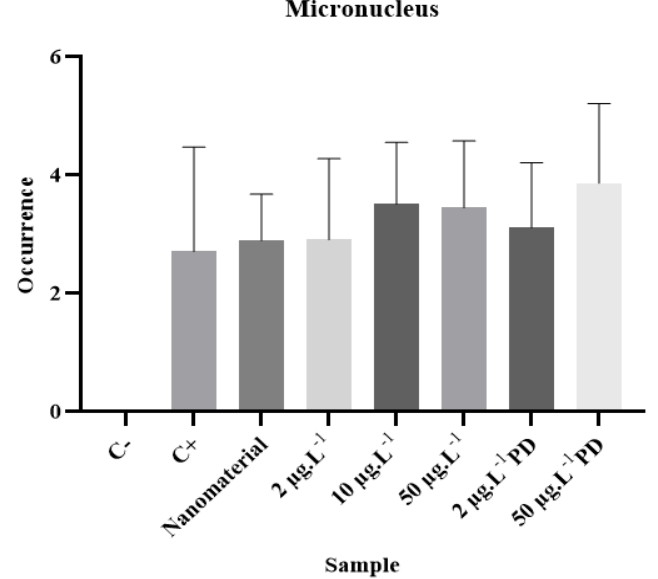
Figure 8. Average values and standard deviations of micronuclei from analyzed samples .